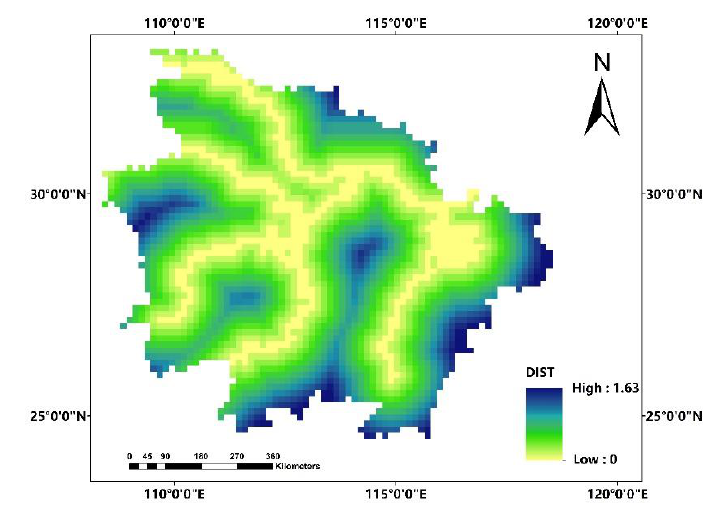
Figure 8. Extreme rainfall frequency.